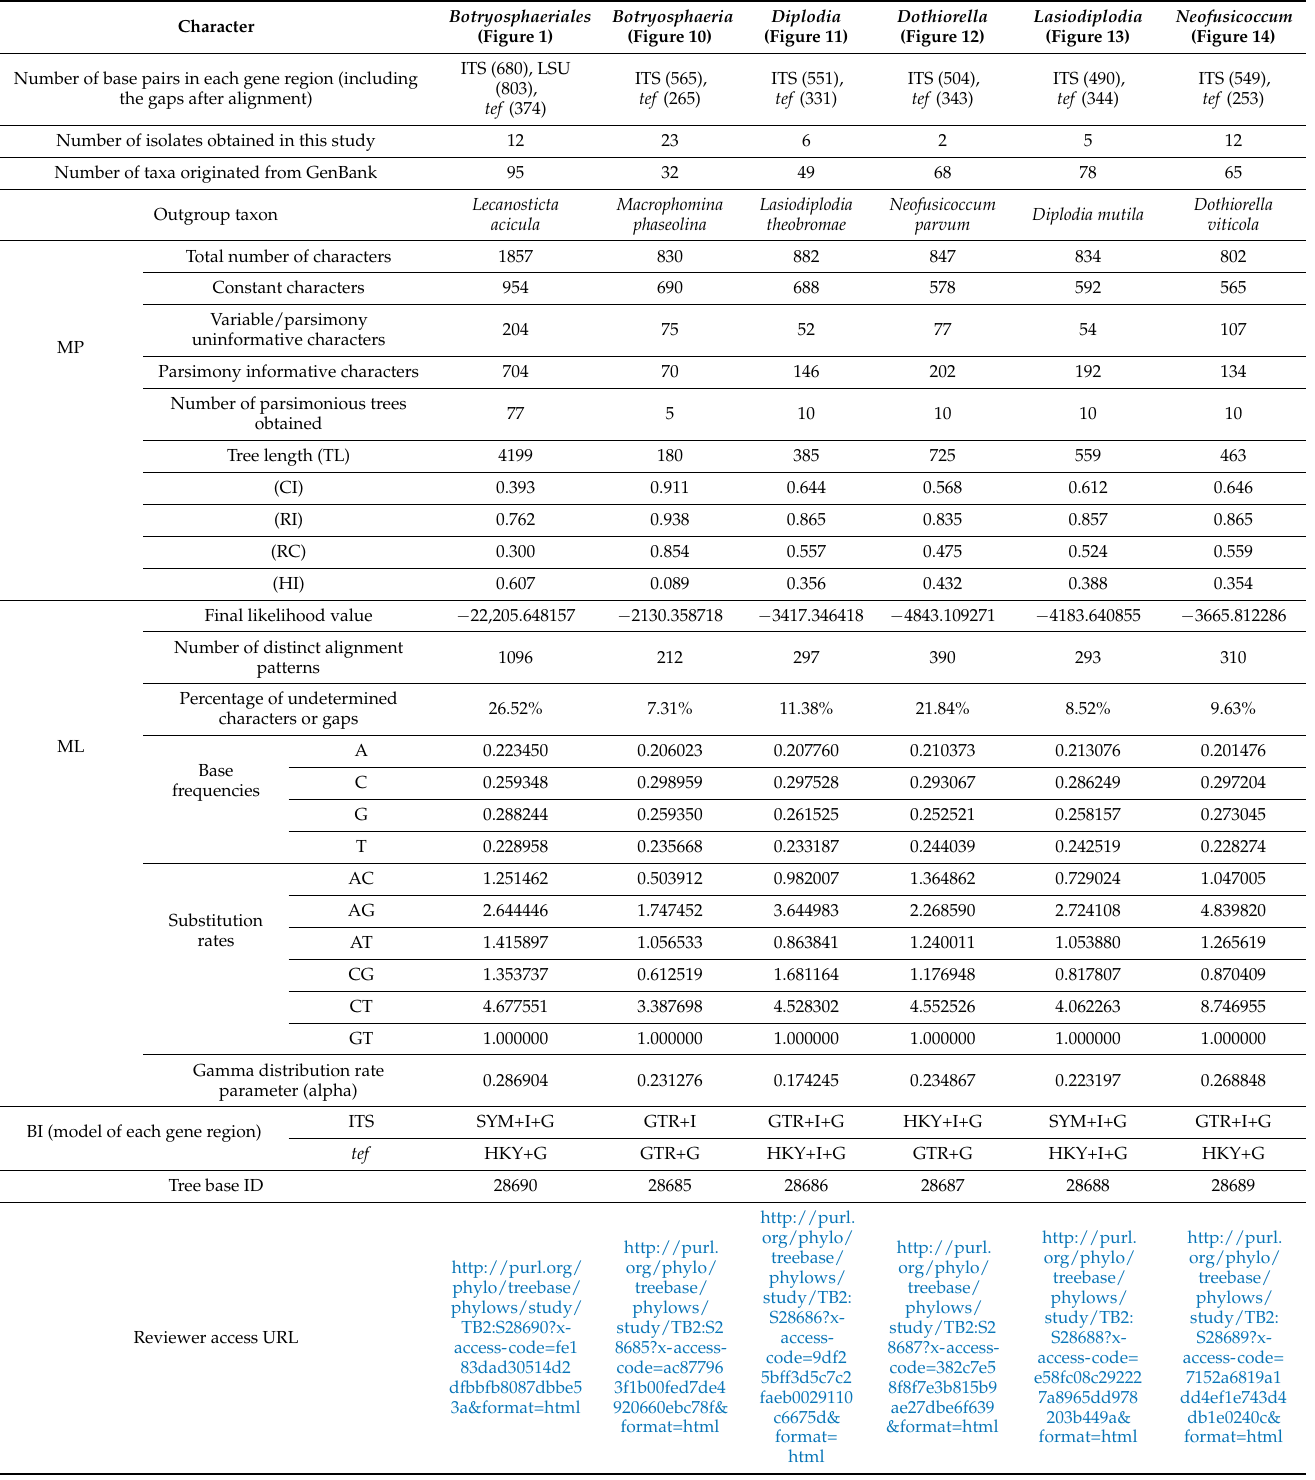
Table 4. Alignment details and comparison of MP, ML, and BI analyses results of each phylogenetic tree constructed in this